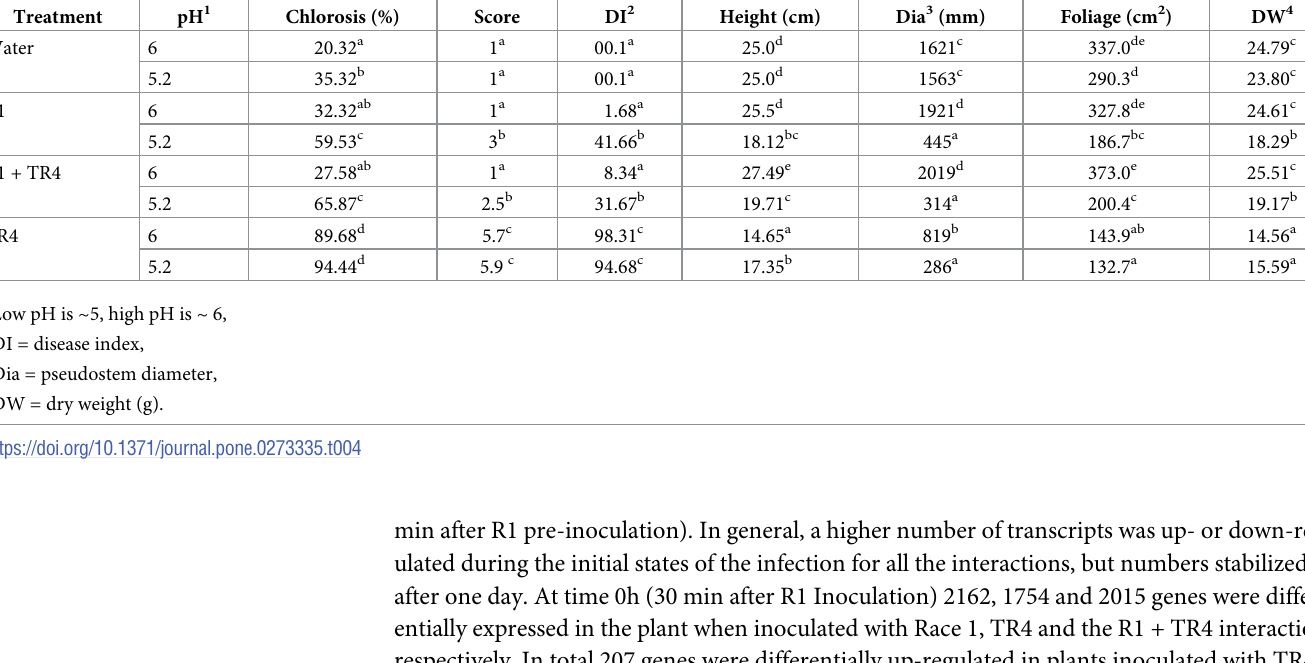
Table 4. Effect of soil acidity on FWB development in Cavendish ‘Grand Naine’, six weeks after inoculation with R1, TR4 and challenge inoculations (R1 + TR4). Treatment pH